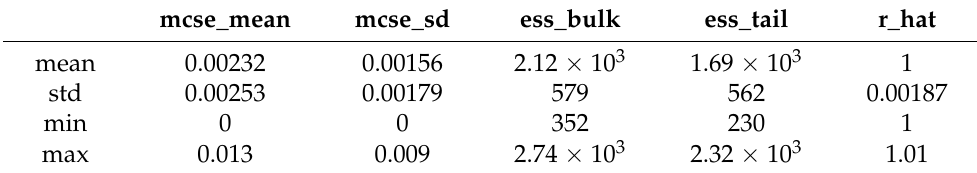
Table 6. Convergence results for types and dates model.